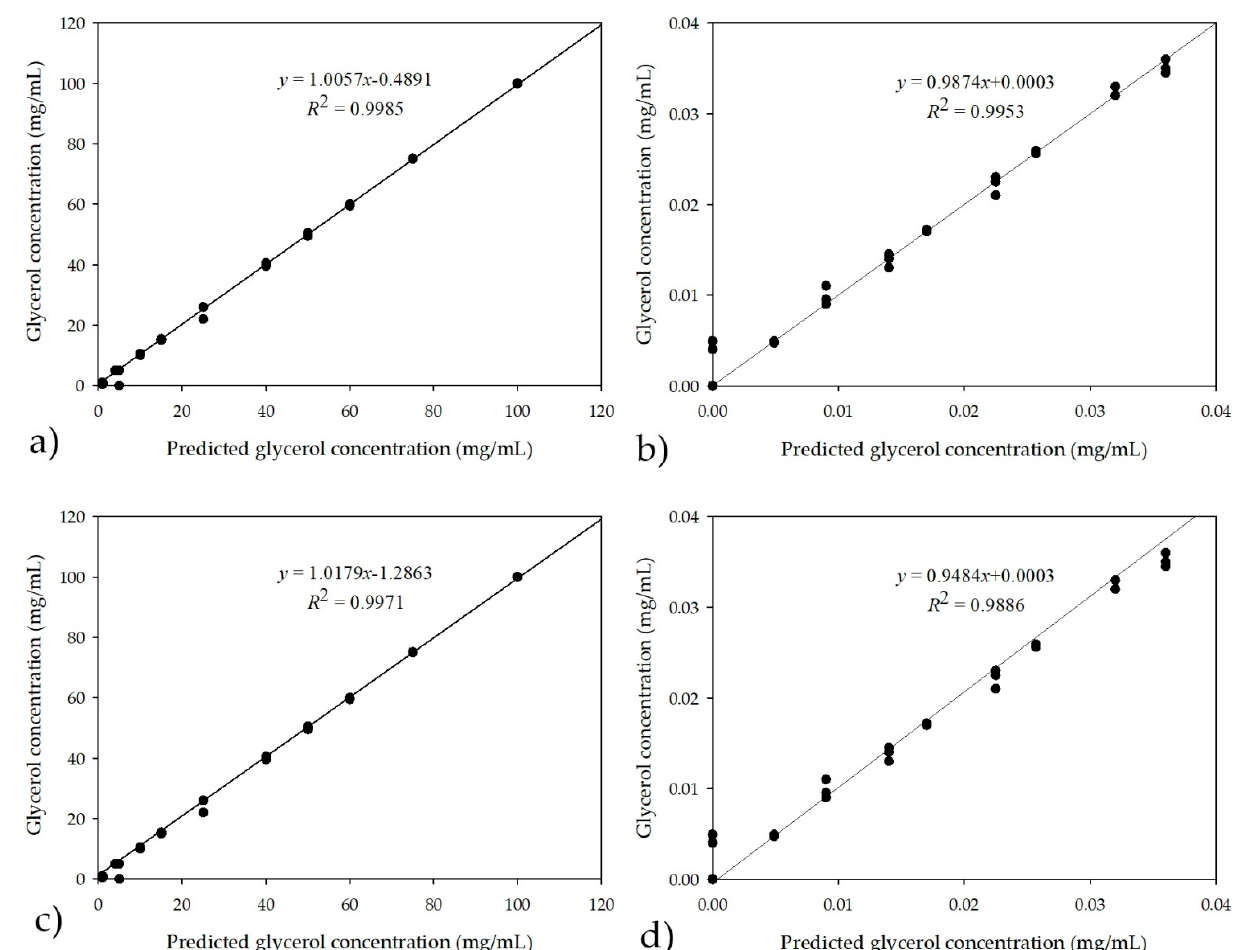
Figure 5. Comparison of glycerol concentration with prediction of selected ANN for different concentration ranges ( a ) from 0 to 100 mg/mL and ( b ) from 0 to 0.035 mg/mL and subsampling ANN prediction for different concentration ranges ( c ) from 0 to 100 mg/mL and ( d ) from 0 to 0.035 mg/mL.